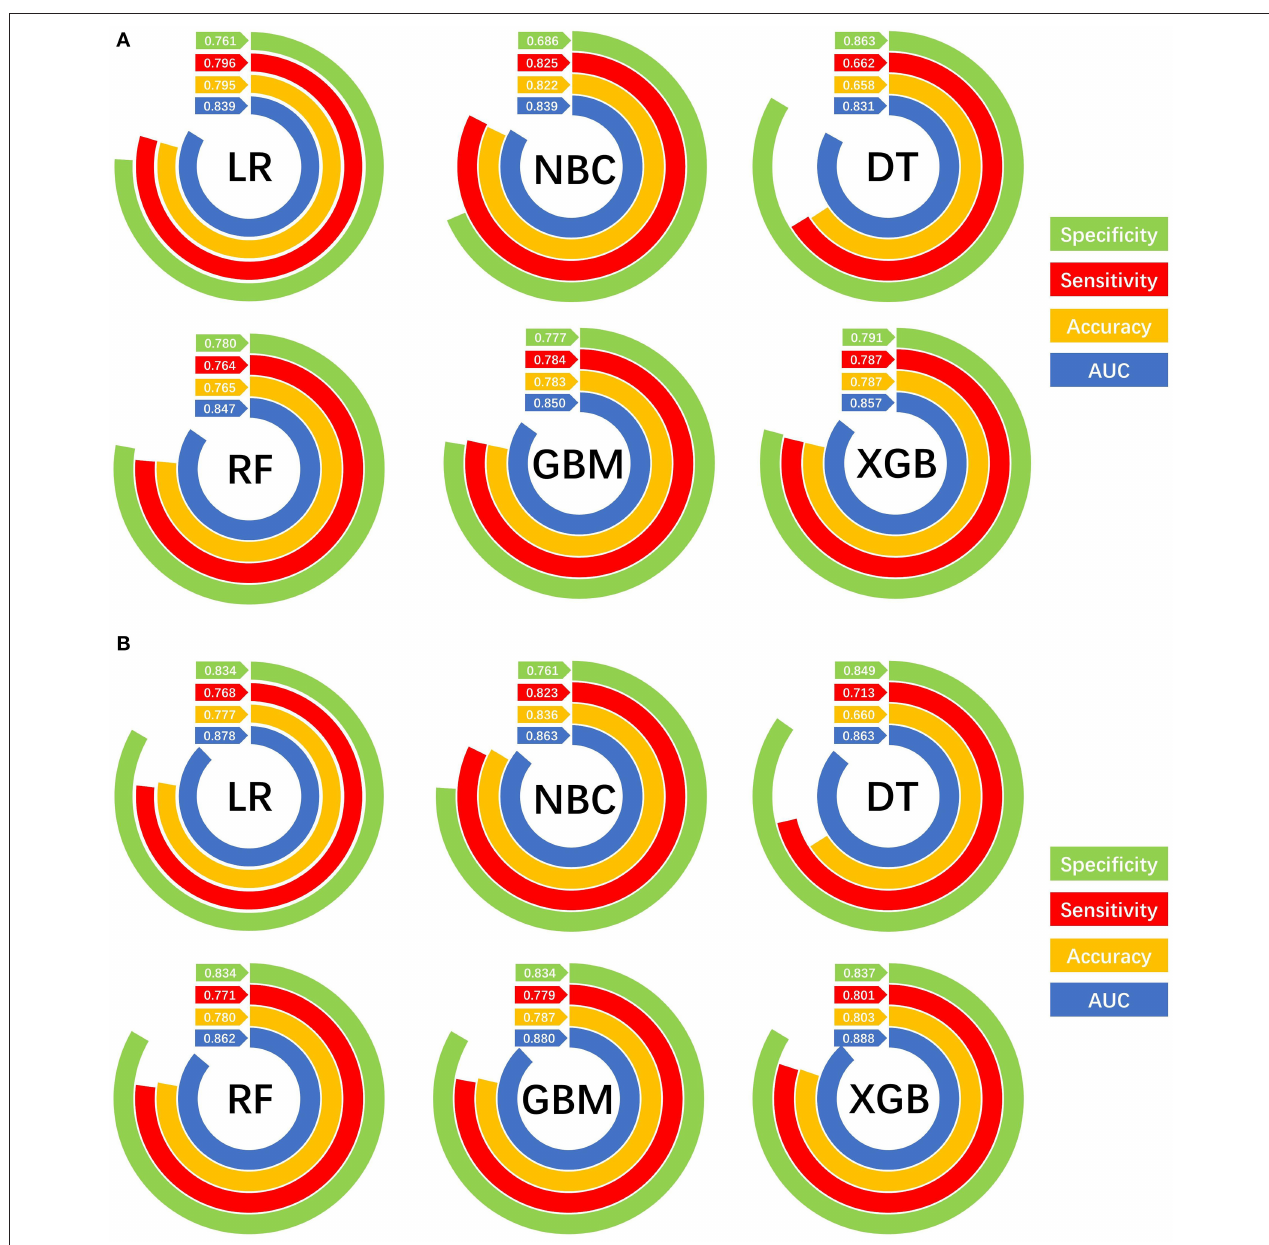
FIGURE 6 | Prediction performances of different machine learning models. (A) Internal validation of different machine learning models. (B) External validation of different machine learning